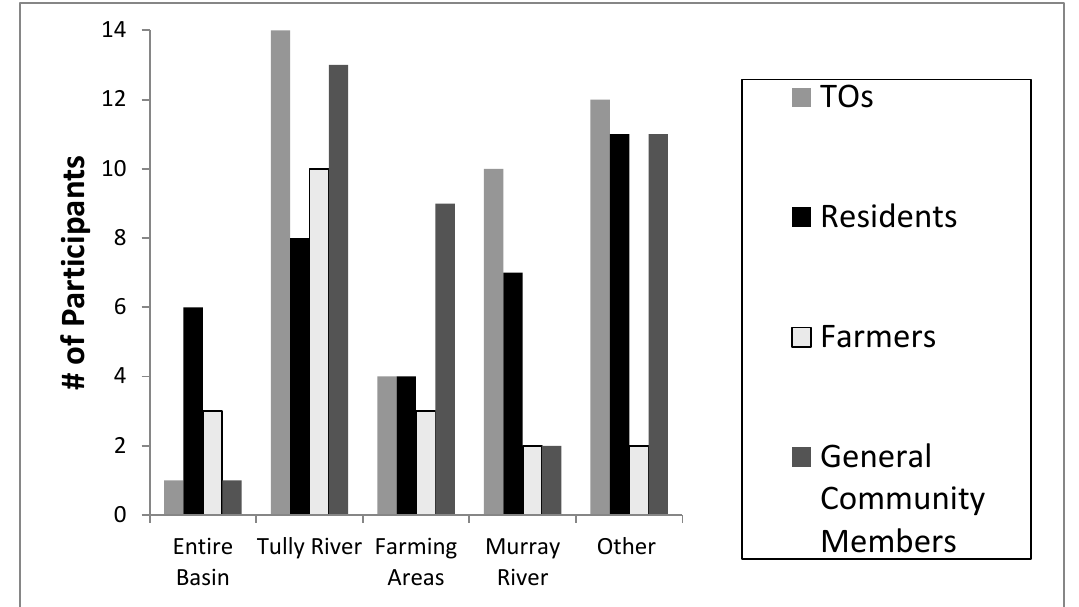
Figure A8. Number of participants who expressed comments about hot spots or priority areas in the basin.